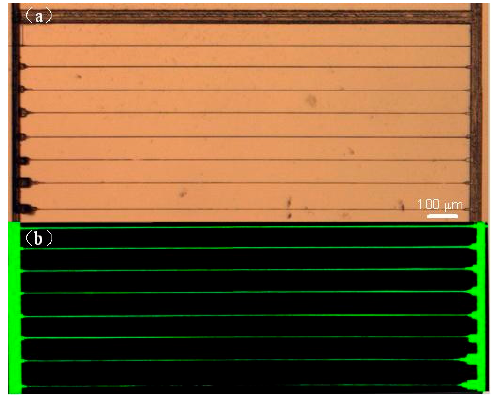
Figure 6. ( a ) Top view optical micrograph of submicrometer channels embedded in porous glass after the postannealing and ( b ) fluorescence microscope image of the postannealed submicrometer channels filled with a fluorescent dye.